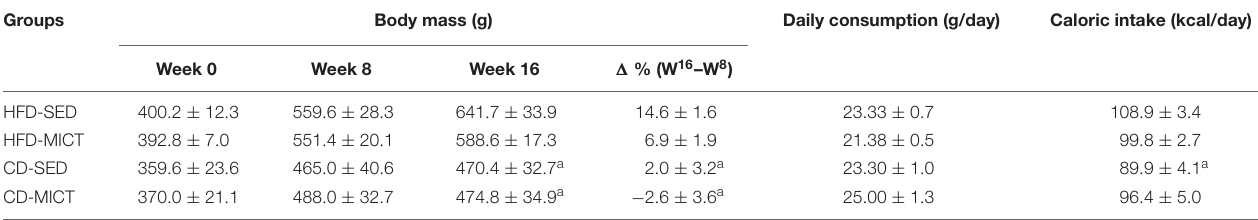
TABLE 1 | Changes in body mass (g) and food intake.